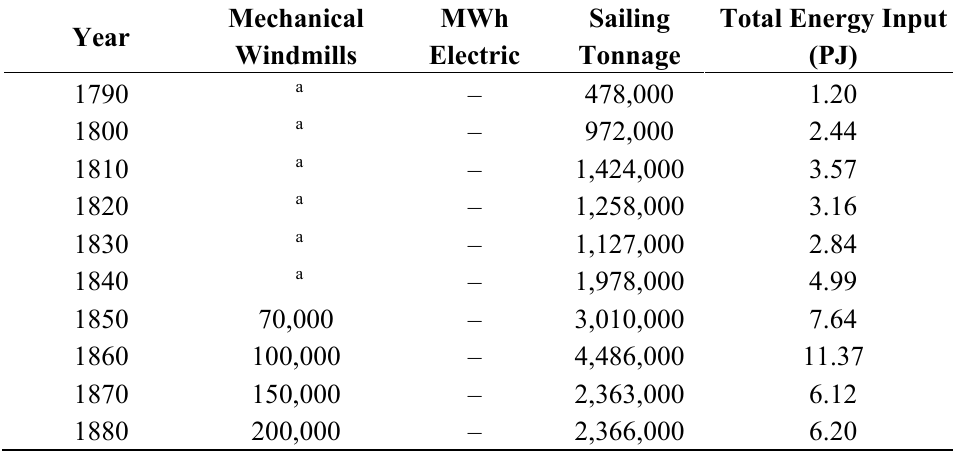
Table 1. Wind energy in the United States, 1790–2010. Sources: Mechanical windmills from [9]. Wind turbine data from [24] for 1980 and [25] for 1990–2010. Energy input calculations based on 36% efficiency of energy extraction for useful work, as in